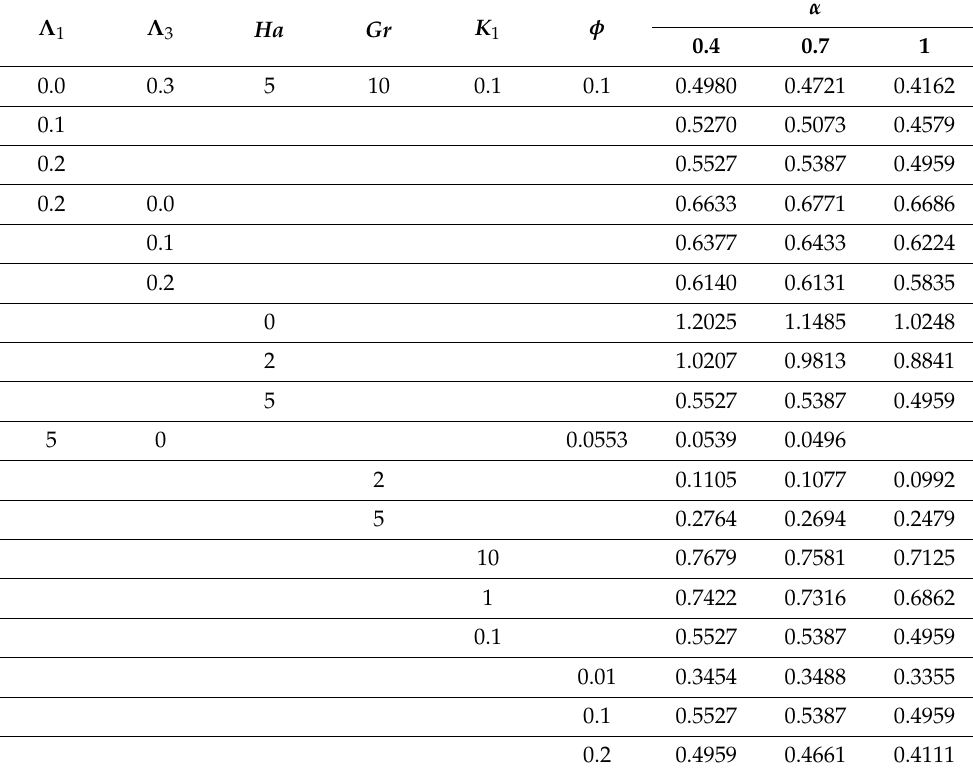
Table 2. Variation in the skin friction coefficient as varying the physical parameters and α .